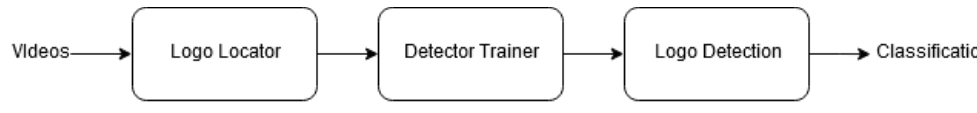
Figure 6. High-level conceptual view of the advertisement detection